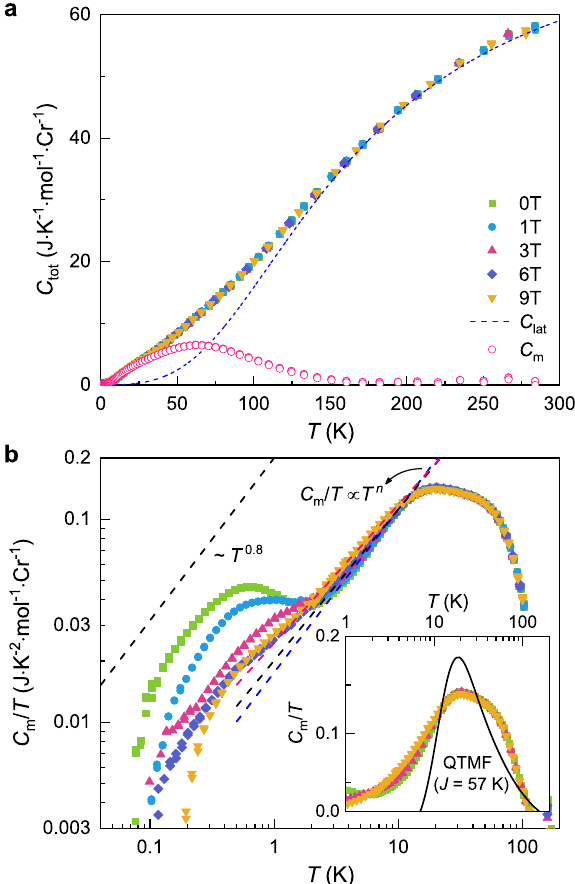
Fig. 2 Heat capacity of the breathing pyrochlore LiGa 0.2 In 0.8 Cr 4 O 8 . a Temperature dependence of the total heat capacity fi elds B = 0, 1, 3, 6, and 9 T. The blue dashed C tot in various magnetic curve denotes the evaluated lattice contributions using the Debye model. The open pink circles represent the magnetic heat capacity T and B dependence of the magnetic heat capacity divided by C m . b temperature C m / T on a double log scale. The dashed lines are fi t to the power-law behavior C m / T ~ T n with n = 0.68 – 0.82. The inset shows a comparison between the C m / T data and the theoretical curve for a s = 3/2 tetrahedron